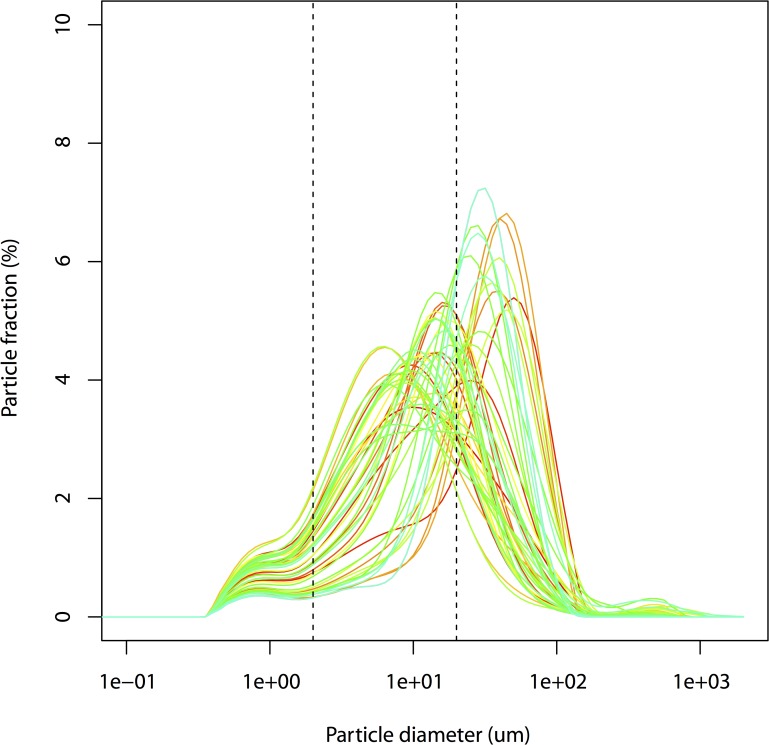
Relatively percentages of particle size volumes in the 48 soil samples.